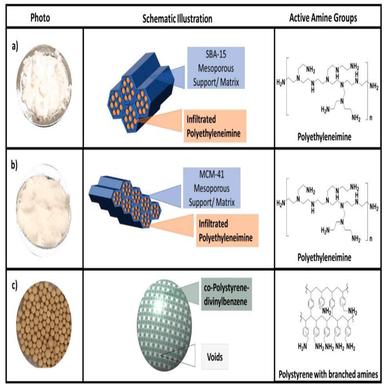
Depictions of amine-based sorbents' appearance at the macroscale (photo), schematic illustrations of the microscale, and active amine groups at the molecular scale for (a, top row) PEI/SBA-15; (b, middle row) PEI/MCM-41 and (c, bottom row) Lewatit VP OC 1065.